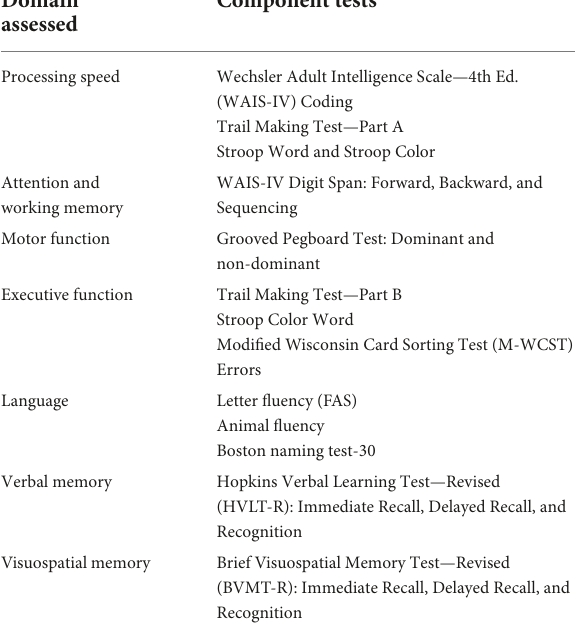
TABLE 2 Component tests of the